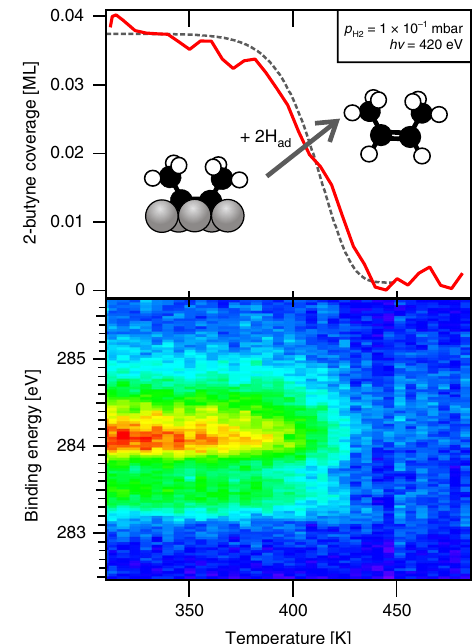
Fig. 5 XPS during heating in a hydrogen atmosphere. Peak area and top view of the C 1s spectra recorded during heating of (~0.04 ML) 2-butyne- covered Co(0001) in the presence of 1 × 10 − 1 mbar H 2 (0.2 K s − 1 , h ν = 420 eV). The experimental data is shown by a solid red line, while the output of our kinetic model is shown as a dashed grey